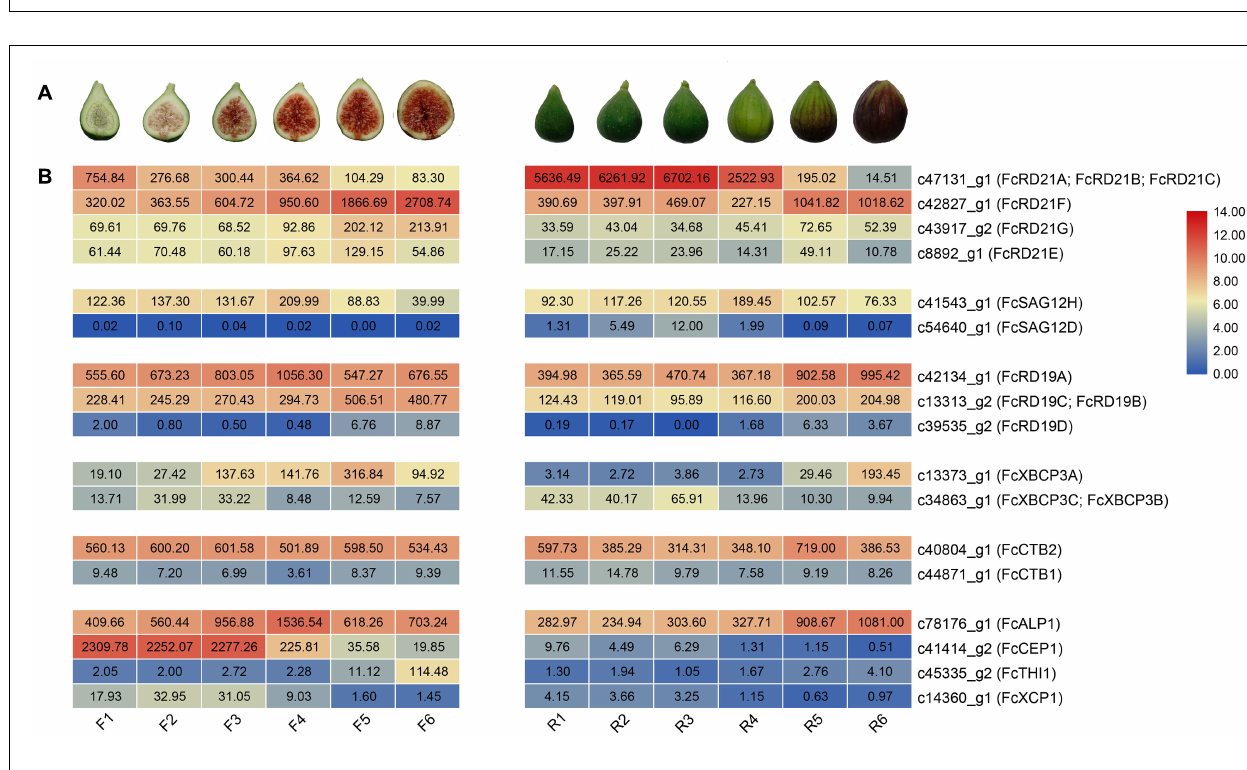
FIGURE 5 | FcPLCP expression during fig fruit development. (A) Images represent six developmental stages of inflorescence (F1–F6) and receptacles (R1–R6). (B) Numbers represent FPKM values. Color scale represents FPKM normalized log2-transformed counts. Blue color, low expression; red color, high expression. FcPLCP s are grouped according to their